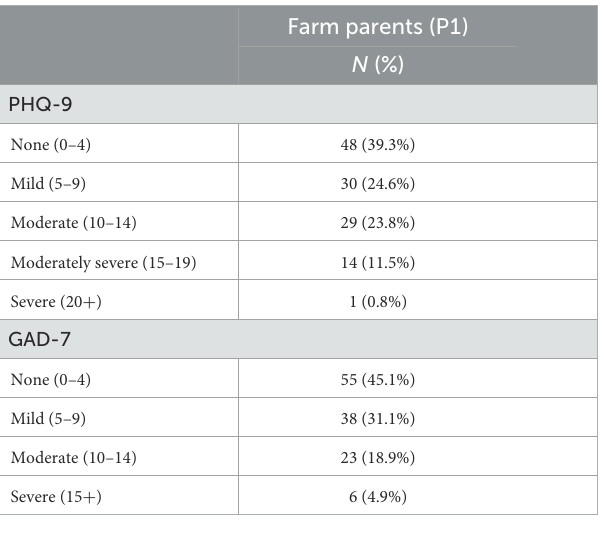
TABLE 3 Symptoms and severity of depression and anxiety among farm parents ( N = 122).